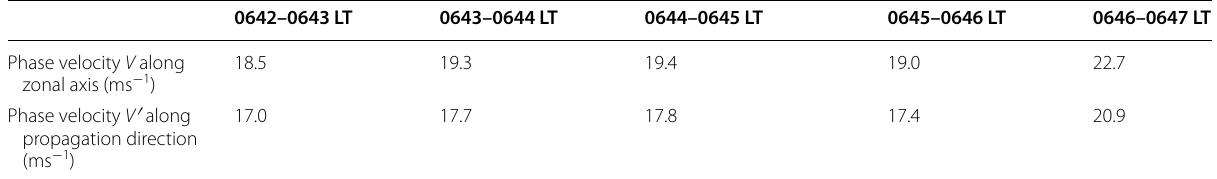
Table 2 Phase velocities obtained from cloud base disturbance tracking from 0642 LT to 0647 LT (see Fig. 14 and text for more